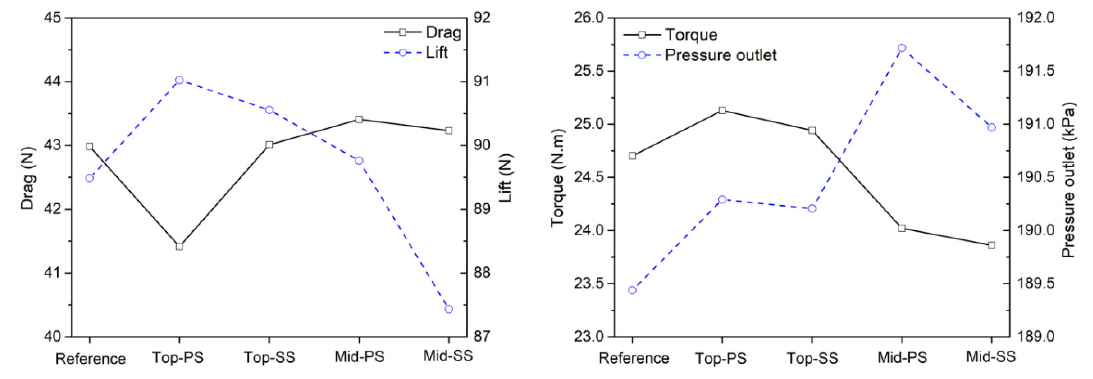
Figure 19. Drag force, lift force, torque, and outlet pressure under various blade conditions.